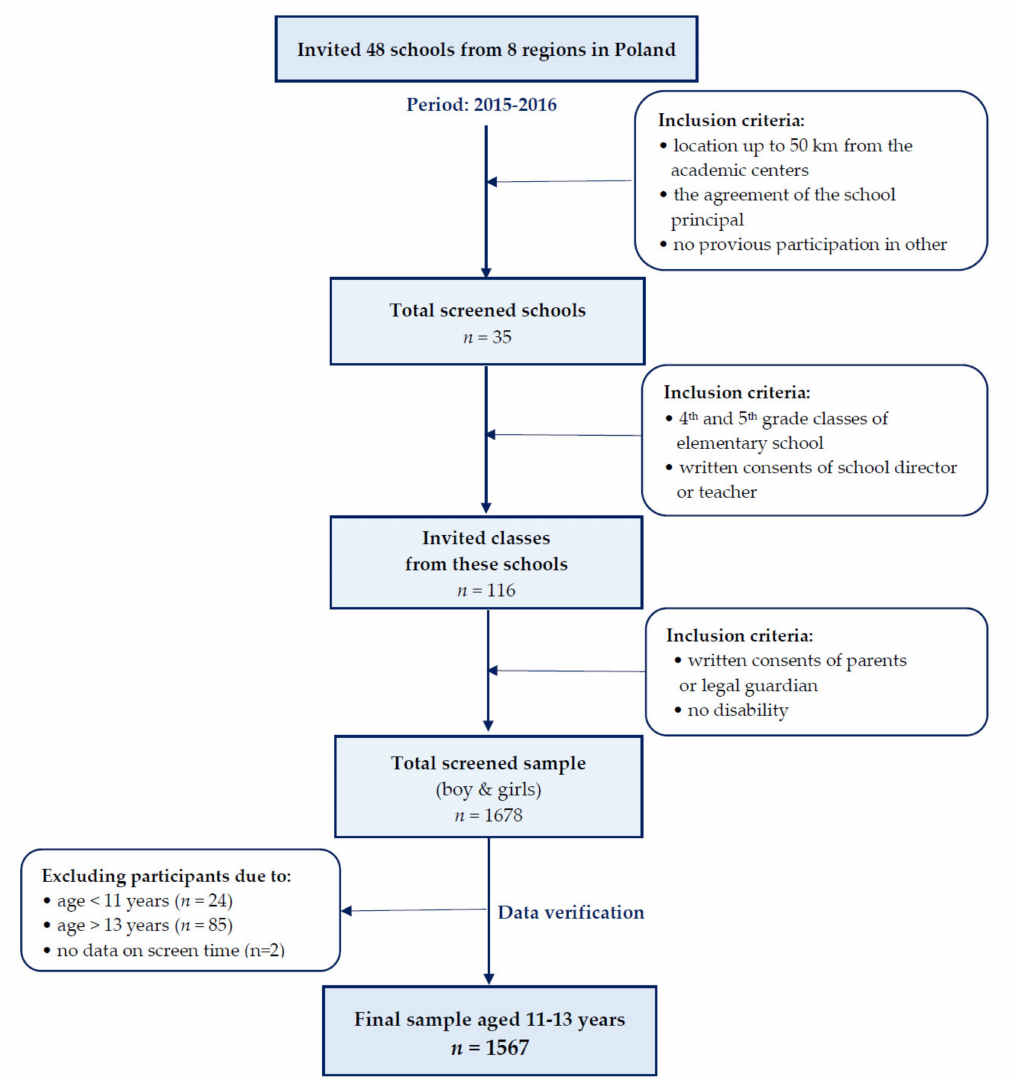
Figure 1. Flowchart of study sample